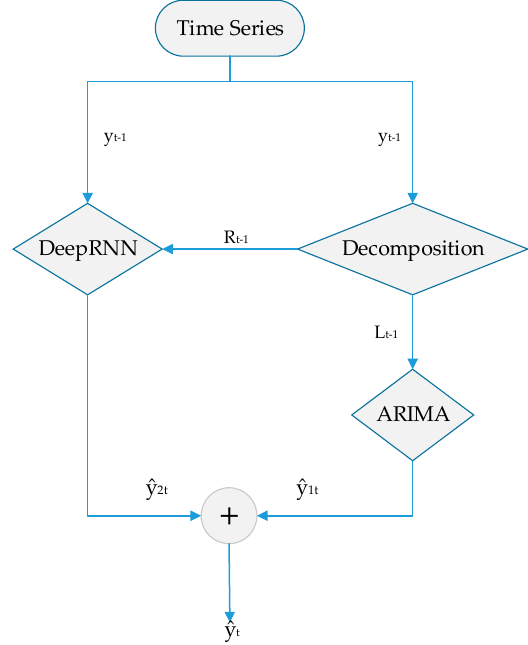
Figure 3. The proposed new algorithm combining Bi-GRU and ARIMA models.